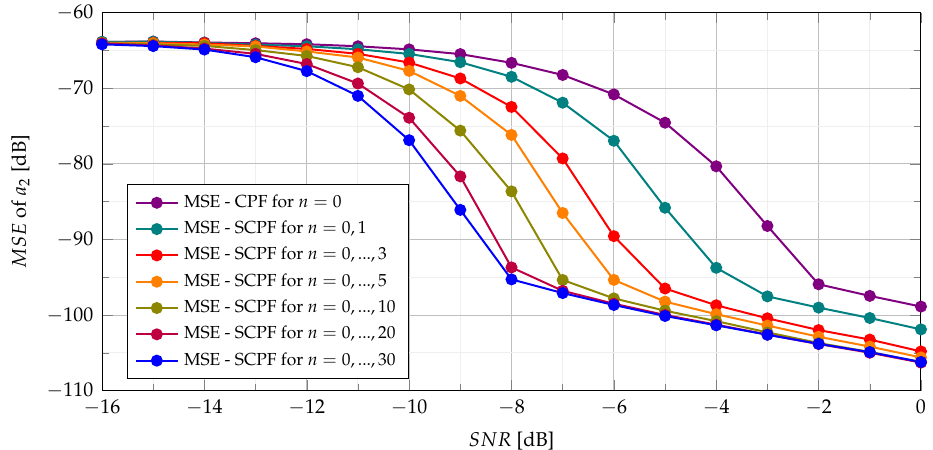
Figure 16. Influence of the number of SCPF slices on MSE for N = 255.